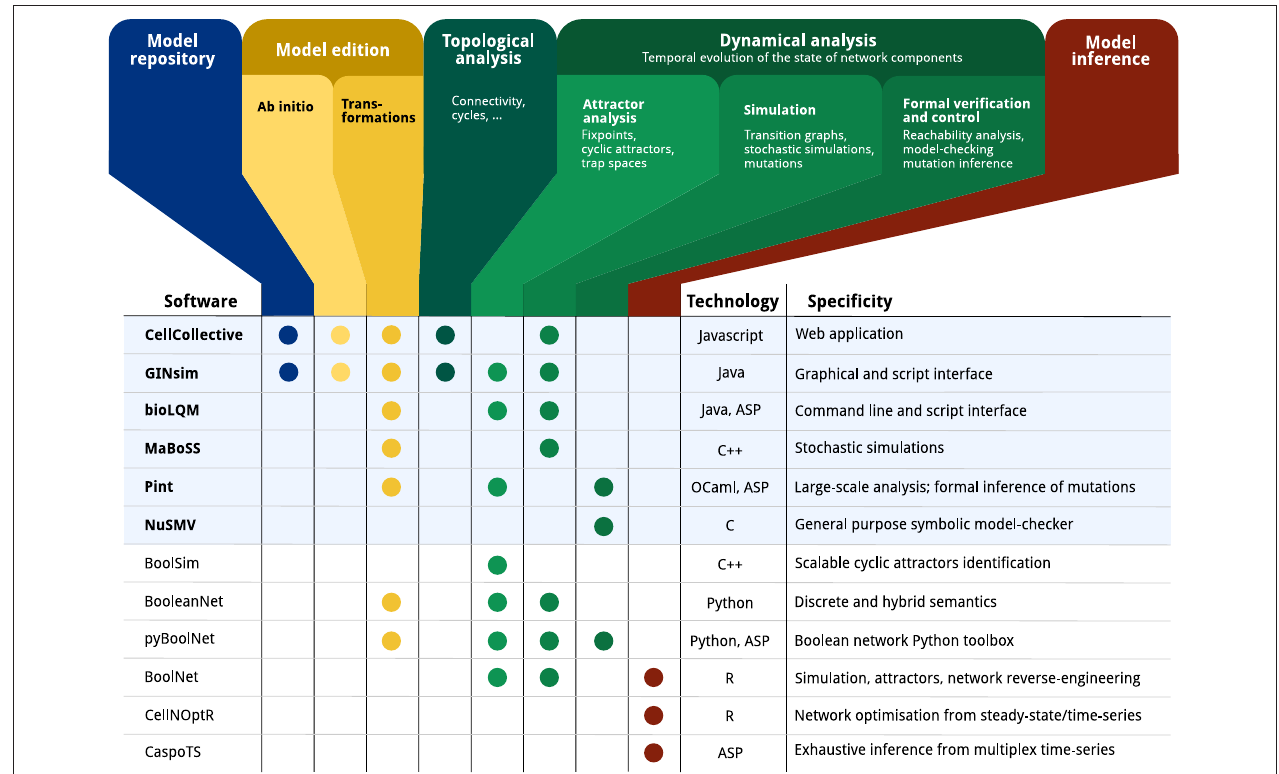
FIGURE 1 | Feature matrix and characteristics of a range of software tools devoted to the qualitative modeling and analysis of biological networks: CELLCOLLECTIVE ( Helikar et al., 2012); GINSIM (Naldi et al., 2018); BIOLQM (Naldi, in review 6 ); MABOSS (Stoll et al., 2017); PINT (Paulevé, 2017); NUSMV (Cimatti et al., 2002); BOOLSIM (Garg et al., 2008 ); BOOLEANNET (Albert et al., 2008); PYBOOLNET (Klarner et al., 2017); BOOLNET (Müssel et al., 2010); CELLNOPT (Terfve et al., 2012); CASPOTS (Ostrowski et al., 2016 ). The current CoLoMoTo Docker (2018-03-31) ships the software indicated with a bold font and a light blue background. “Model repository” refers to searchable databases of models; “Model edition” refers to the features related to creating and modifying a qualitative model, where “ ab initio ” refers to the interactive model building from scratch, and “transformations” refers to operations such as mutations, Booleanization, model reduction, etc. “Topological analysis” refers to the extraction of features from the regulatory graph, such as the different feedback cycles, graph theory measures, etc. “Dynamical analysis” refers to properties related to the state transition graph of Boolean/multi-valued networks, where “Attractor analysis” refers to the identification of stable states, cyclic attractors, and related features; “Simulation” refers to the sampling of trajectories within the state transition graph, possibly parameterized with stochastic rates and mutations; “Formal verification and control” refers to exhaustive analyses for assessing strictly temporal properties, such as reachability, and deducing mutations for controlling the system. Finally, “Model inference” refers to the derivation of Boolean/multi-valued network which are compatible with given properties and observation